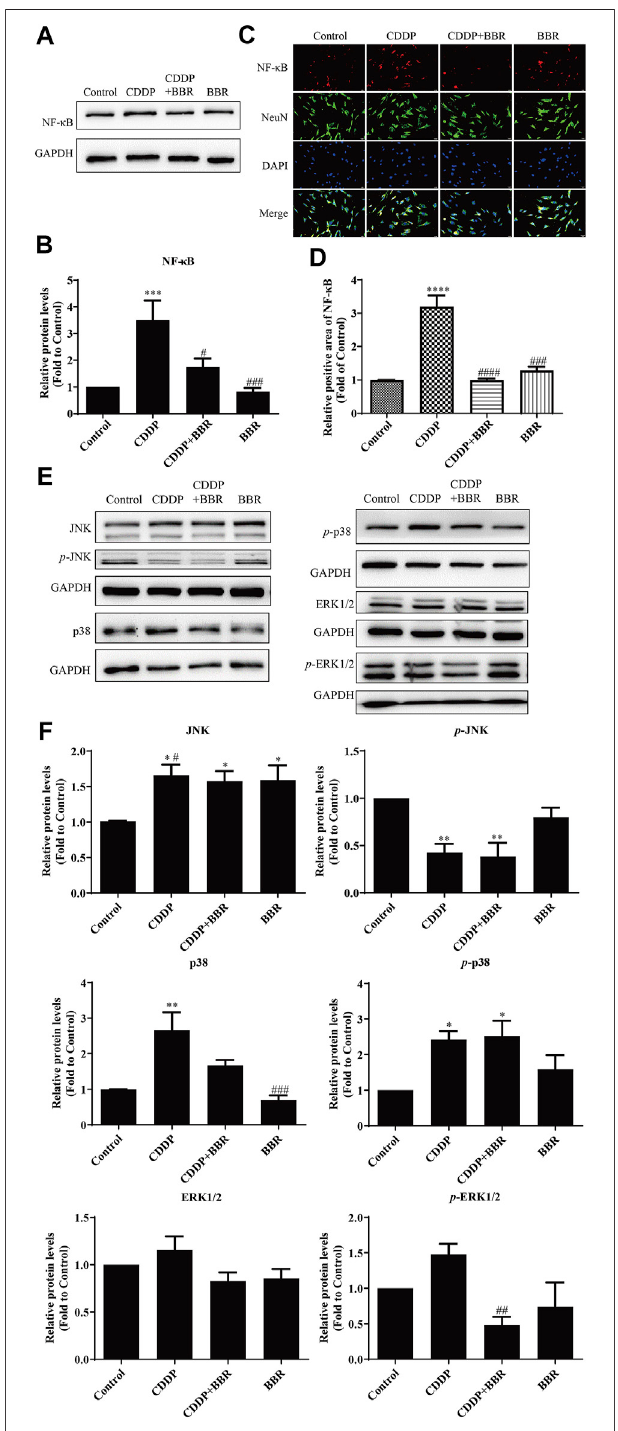
FIGURE 9 | BBR inhibits the overexpression of NF- κ B in DRG neurons inducedbyCDDP. (A,B) BBRinhibitstheoverexpressionofNF- κ Binducedby CDDP ( F (cid:1) 9.178, p (cid:1) 0.0002). (C) Immuno fl uorescence staining showed NF- κ B relative abundance induced by CDDP and BBR stimulation in DRG cells NeuN labeled neurons. Scale bar (cid:1) 20 μ m. (D) The quantitative of immuno fl uorescence showed that 3 μ M BBR alleviates the expression of NF-